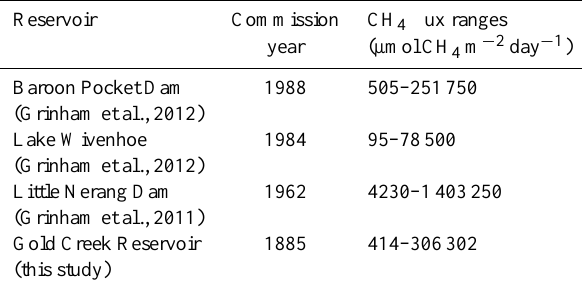
Table 5. The range of methane fluxes across selected reservoirs (covering shallow and deep sites) in South East